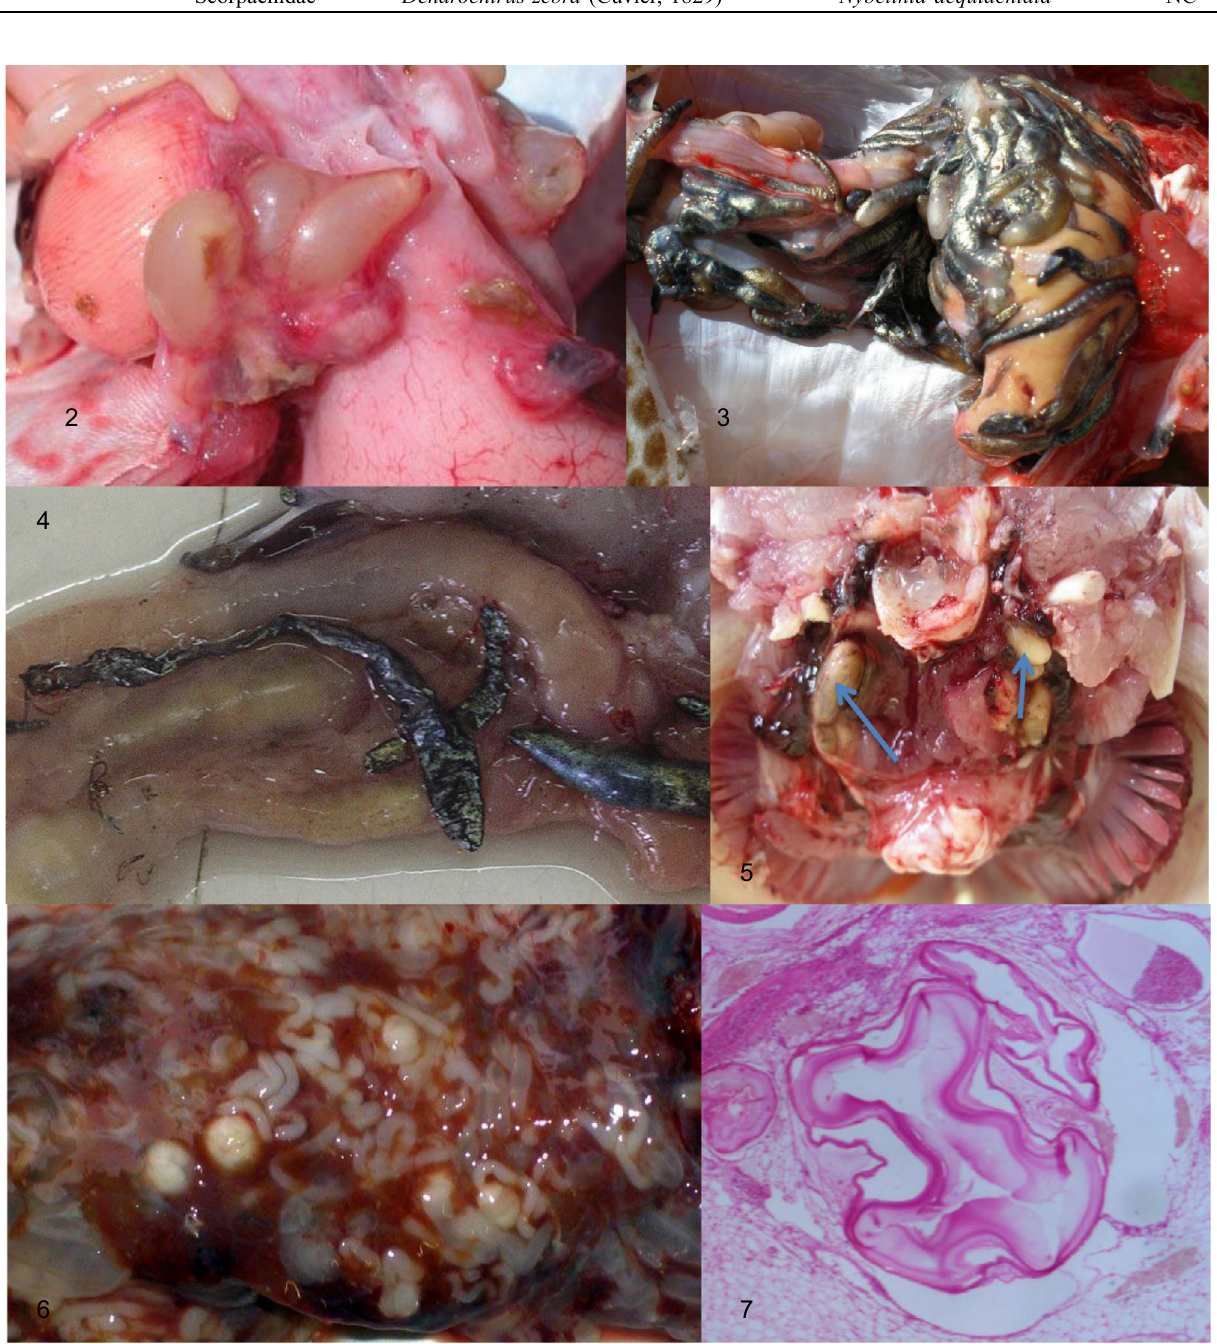
Figures 2–7. Metacestodes of trypanorhynch cestodes from teleost fishes. 2. Viable plerocerci of Callitetrarhynchus gracilis in the body cavity of Scomberomorus commerson . 3 . Melanised trypanorhynch plerocerci in the body cavity of Epinephelus sp. 4 . Melanised and contracted cysts of trypanorhynch metacestodes in the body cavity of Cephalopholis miniata ; no viable plerocerci were recovered from these cysts. 5 . Plerocerci of Pseudogilquinia spp. (arrows) around the oesophagus of Lethrinus nebulosus . 6 . Merocerci of Molicola horridus in the liver of Diodon hystrix . 7 . Plerocerci of Grillotiella exile in the gill arches of Scomberomorus commerson (histological